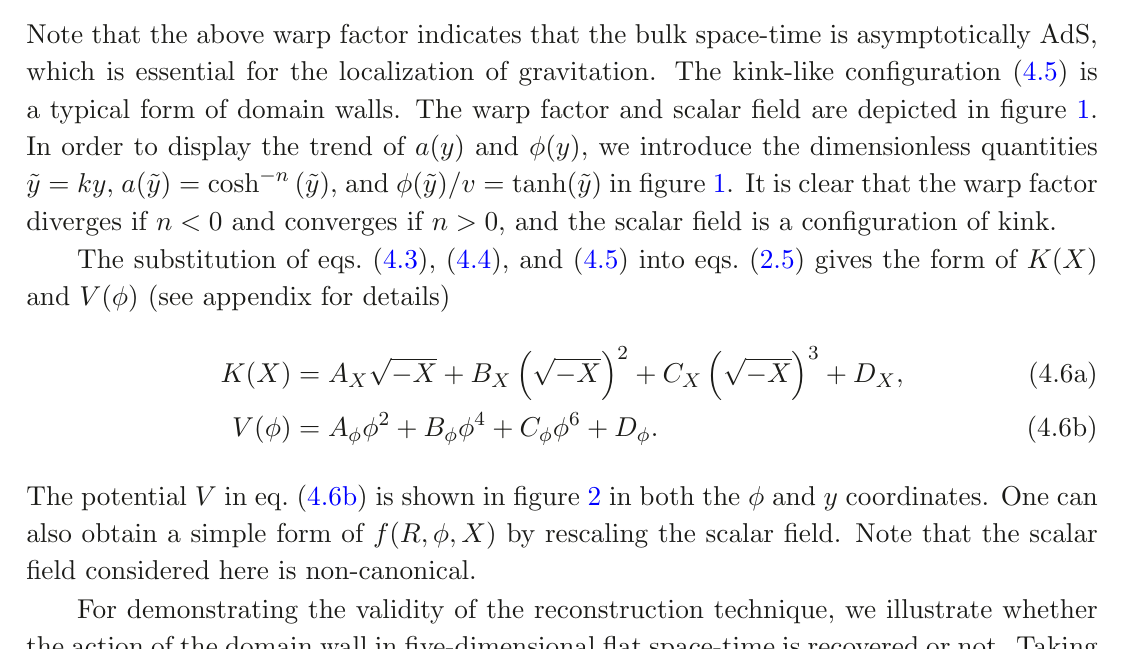
Figure 1. Plots of a (˜ y ) and φ (˜ y ) /v , where a (˜ y ) is the warp factor in eq. (4.4) and φ (˜ y ) is the scalar field in eq. (4.5) . The parameter is set to n = (3 , 1 , By substituting the form of f ( R, φ, X ) in (4.3) into eqs. (2.5) and (2.6), we can